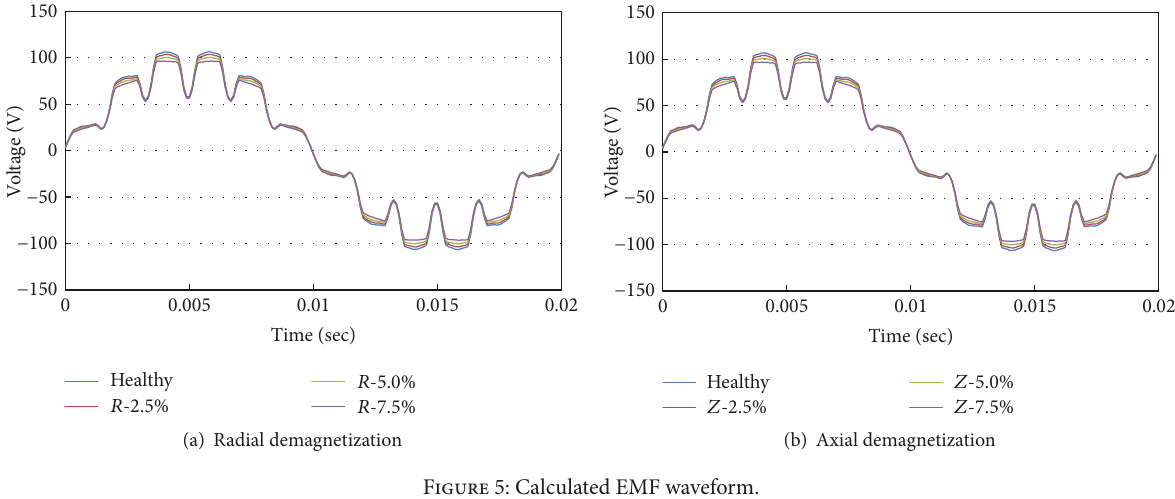
Figure 5: Calculated EMF waveform.